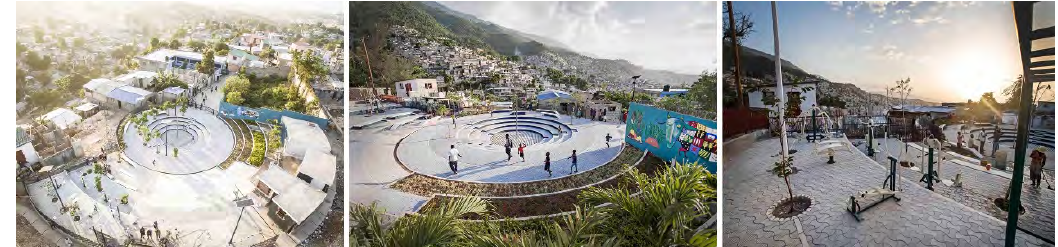
Figure 5. Shots showing the project’s urban spaces. Source: Archdaily,